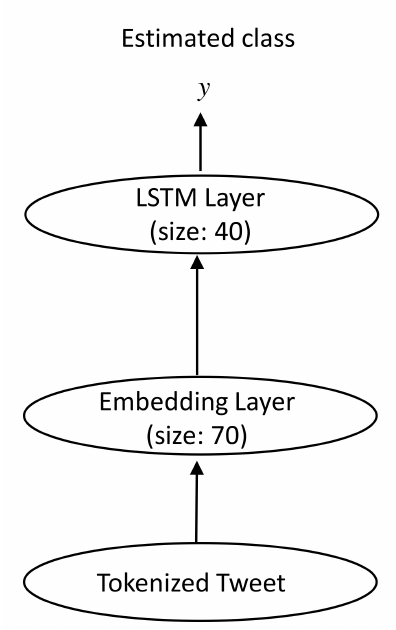
Figure 8. The layers used in the training process of the LSTM network.